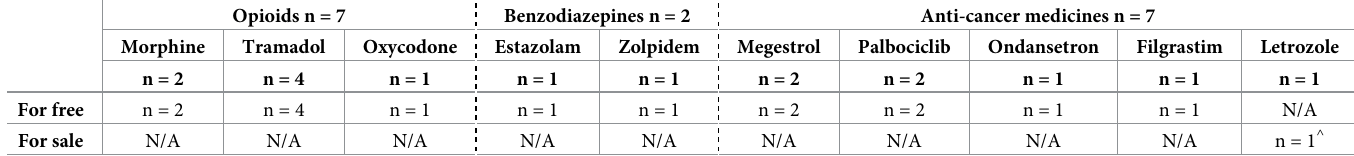
Table 2. The structure of offers related to opioids, benzodiazepines, and anti-cancer medicines #